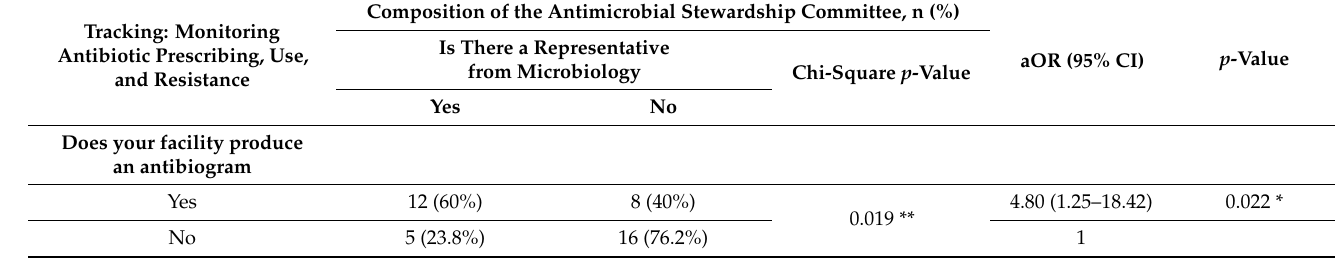
Table 6. Bivariate Chi-squared test of association: associations between drug and antimicrobial expertise (infectious disease physician) and reporting information to staff on improving antibiotic use. Drug and Antimicrobial Expertise, n Reporting Information to Staff on Improving Antibiotic Use